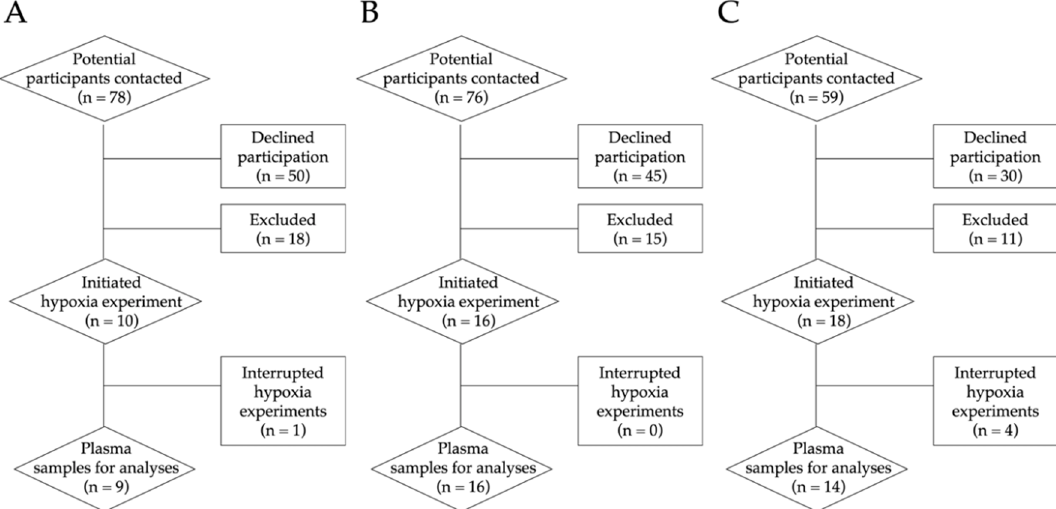
Figure A1. Flow chart of recruitment process for the human experimental model. Out of 213 potential participants allocated into 78 OHT patients, 76 NTG patients, and 59 controls, plasma samples were collected from 9 patients with OHT ( A ), 16 patients with NTG ( B ), and 14 controls ( C ) that completed the experimental setup.